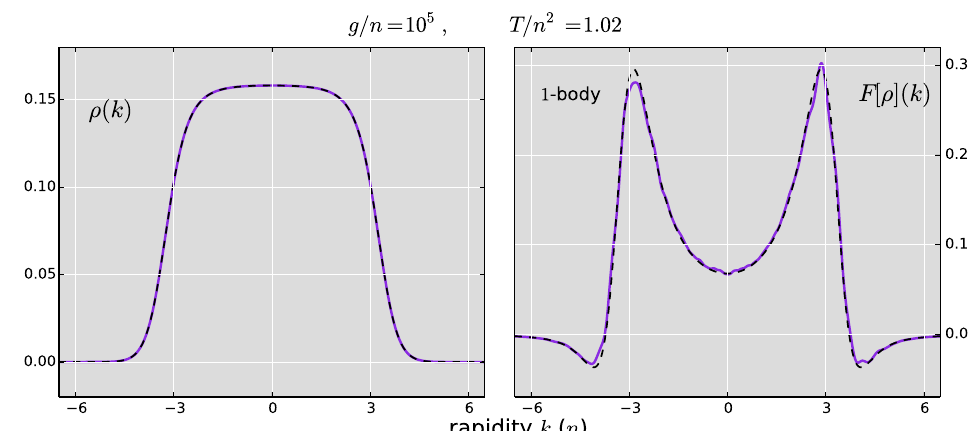
Figure 3: Left: rapidity distribution for the thermal state at T = 1.02 n 2 and g = 10 5 n , compared with the Fermi-Dirac distribution (black dashed line). Right: numerical evaluation of the functional F [ ρ ]( k ) for K = 1, compared with the exact formula (14) for the hard-core limit (black dashed line). The agreement is excellent and serves as a further validation of the numerical method. The curve is obtained by summing over 10 4 independent pairs of Bethe states with N (cid:39) 30 particles. A Gaussian of width σ = 0.12 n is used to smoothen the rapidity